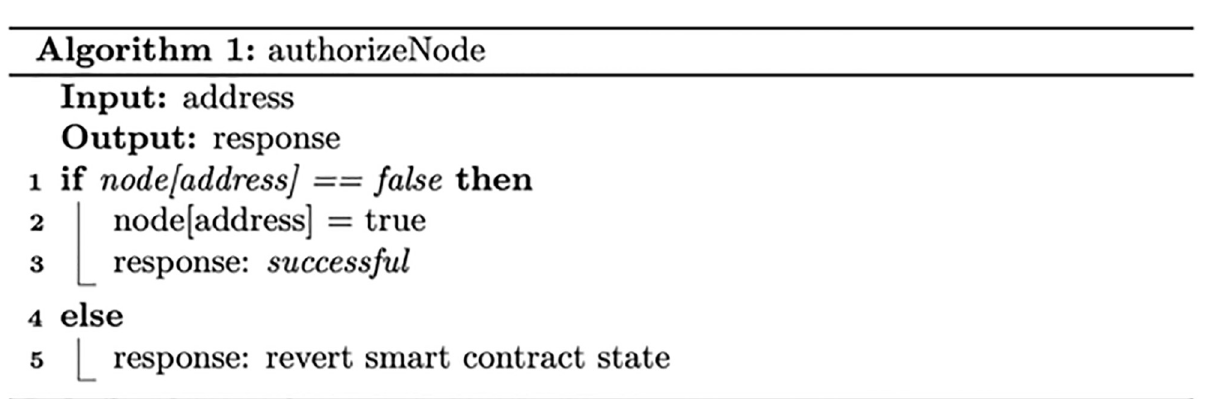
Fig 2. Node granting authorisation